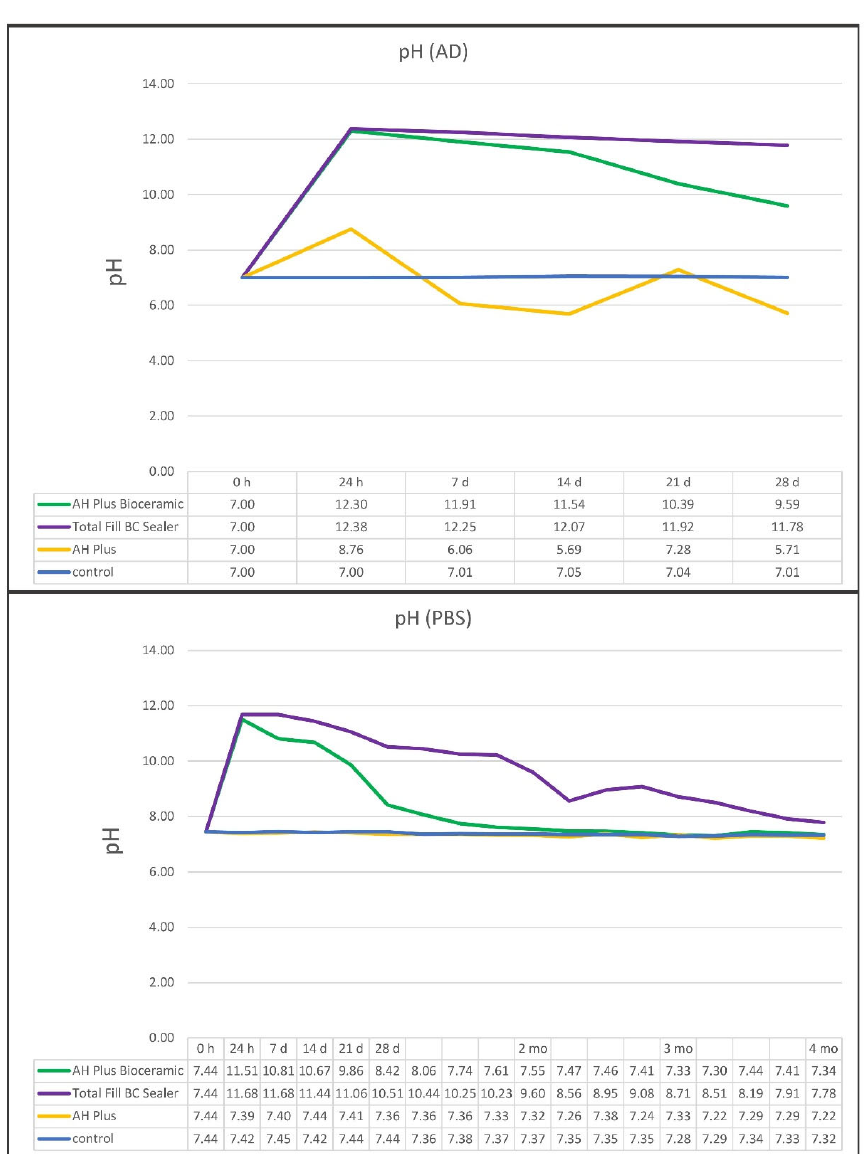
Figure 1. pH of AH Plus Bioceramic Sealer, Total Fill BC Sealer, and AH Plus in distilled water (AD) over 28 days and in PBS over 4 months, respectively .